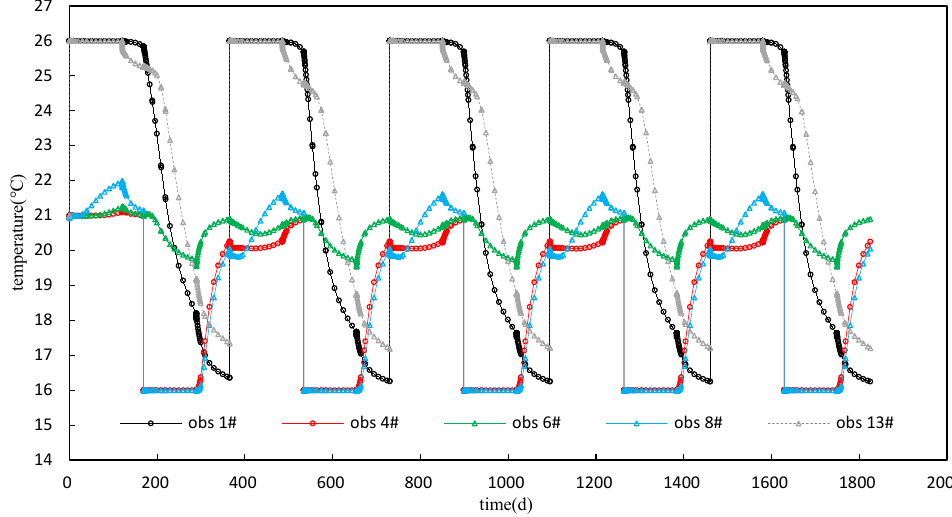
Figure 8. Temperature vs. time for observation wells (F2).